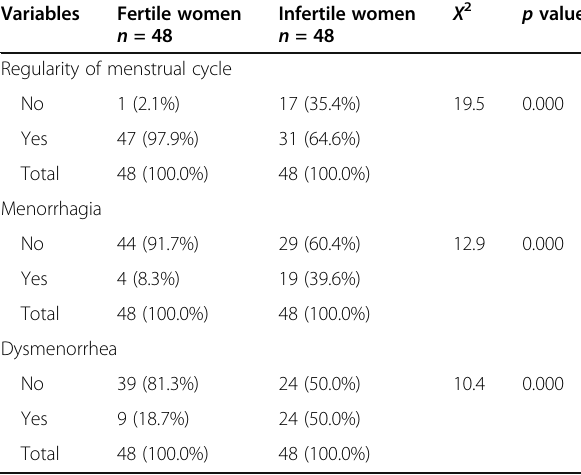
Table 2 Gynaecological findings of fertile and infertile